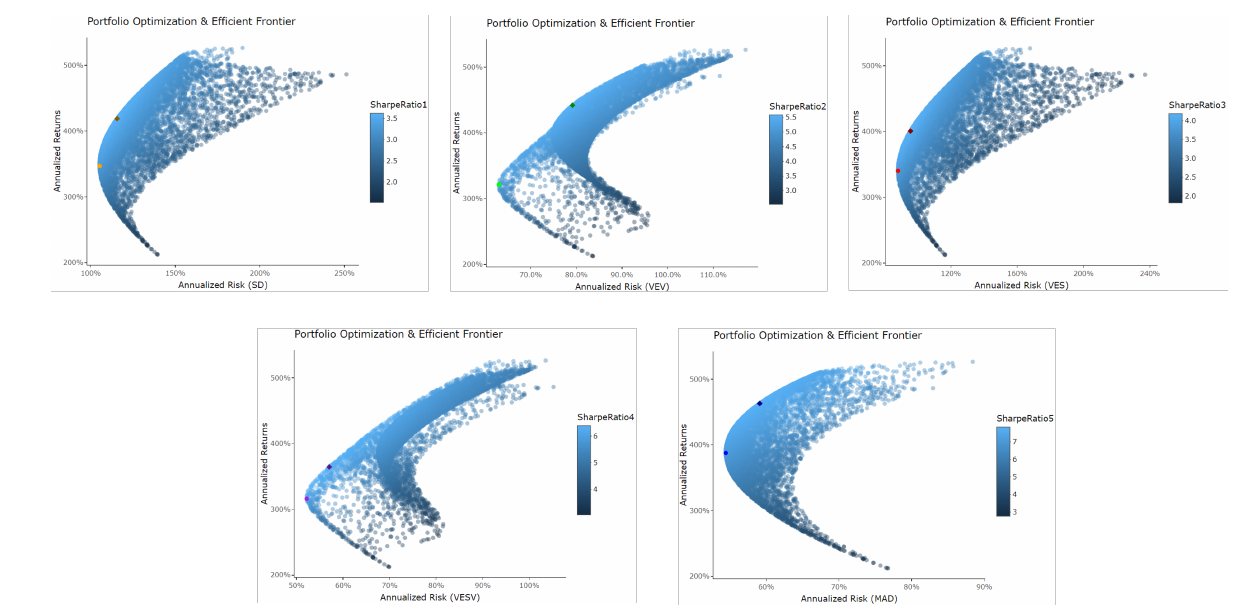
Figure 15. Efficient frontiers of Cryptocurrencies (Group 2).